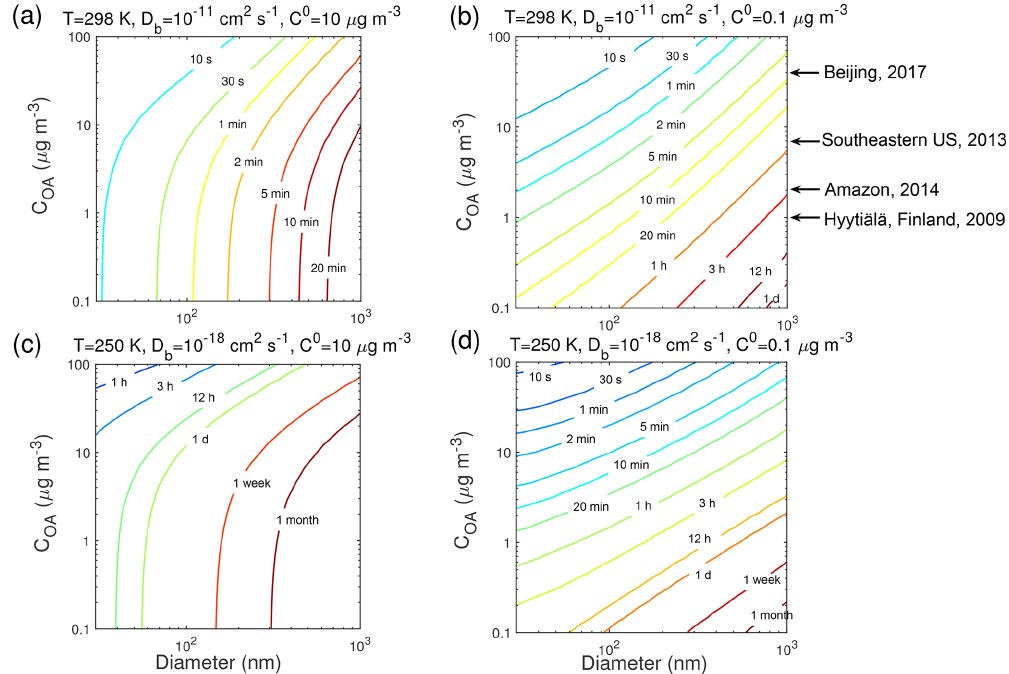
Figure 6. Equilibration timescale ( τ eq ) for (a, c) SVOC ( C 0 = 10µgm − 3 ) and (b, d) LVOC ( C 0 = 0 . 1µgm − 3 ) as a function of parti- cle diameter (nm) and mass concentration (µgm − 3 ) of preexisting particles at 60% RH and T of (a, b) 298K and (c, d) 250K in the closed system. The glass transition temperature of preexisting particles under dry conditions ( T g , org ) is set to 270K, which leads to D b of (a, b) 10 − 11 cm 2 s − 1 and (c, d) 10 − 18 cm 2 s − 1 . Ambient organic mass concentrations are indicated with